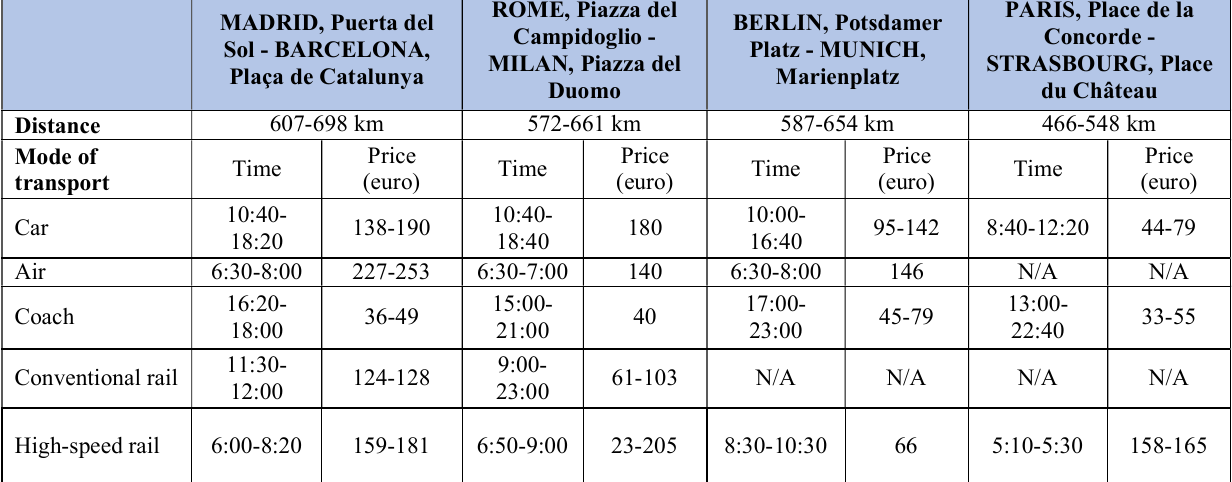
Table 2. Door-to-door travel analysis on selected HSR routes